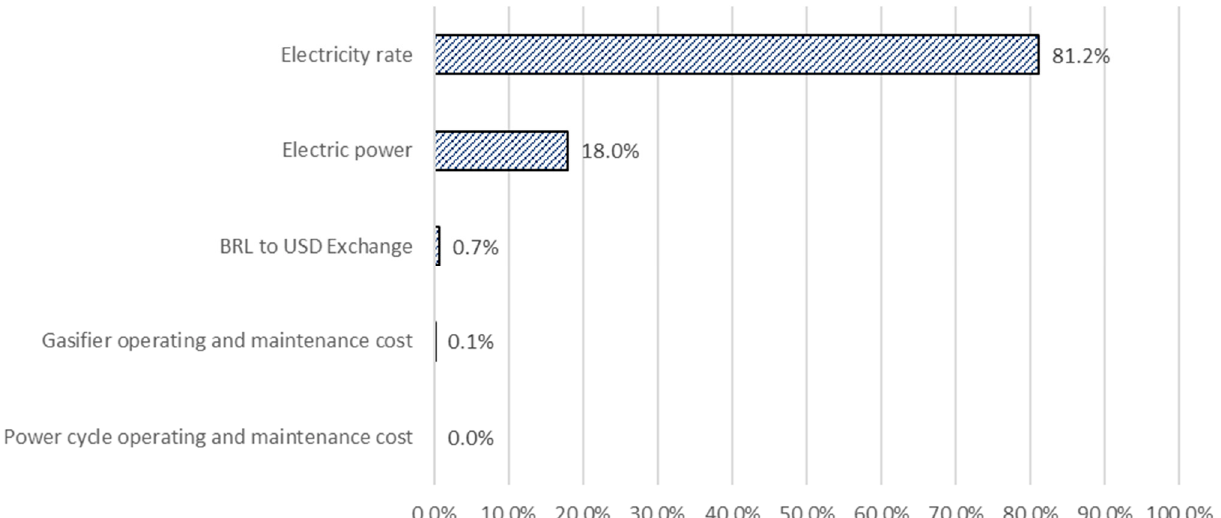
Figure 13. Assumption contribution to NPV variance of power system based on air as a gasifica- tion agent.